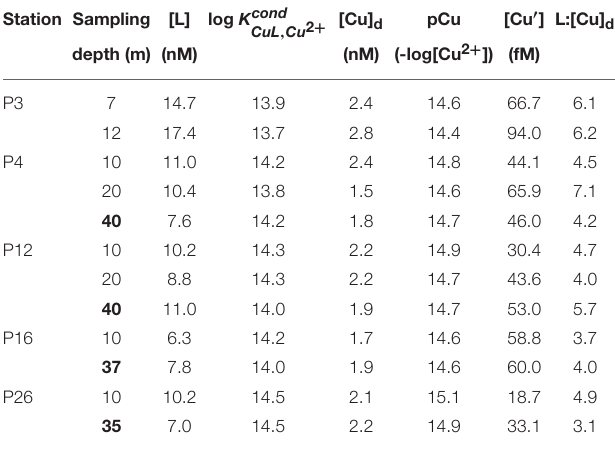
TABLE 3 | Total dissolved Cu, ligand concentrations, conditional stability constants, inorganic Cu concentration, and the dissolved [L]:[Cu] d ratio at each sampling depth along Line